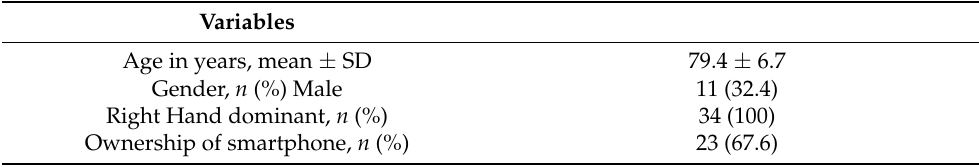
Table 1. Characteristics of the study sample ( n = 34).